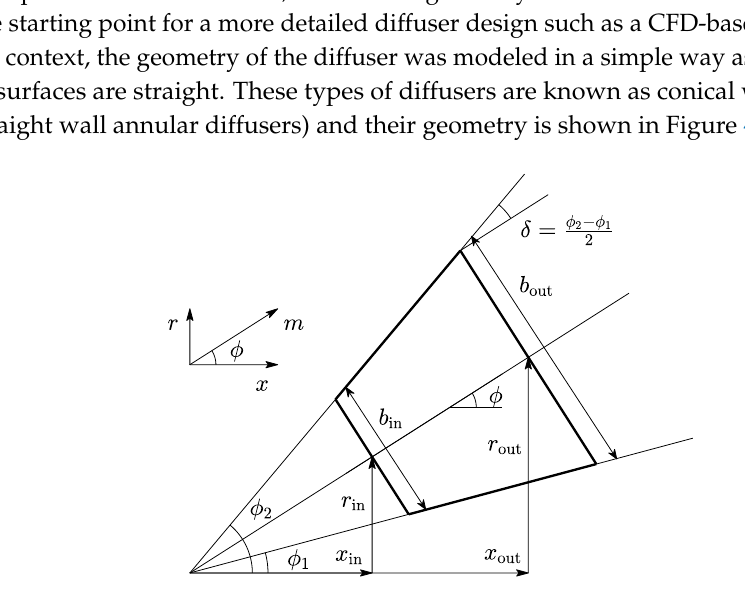
Figure 4. Axial–radial view of an annular diffuser with straight